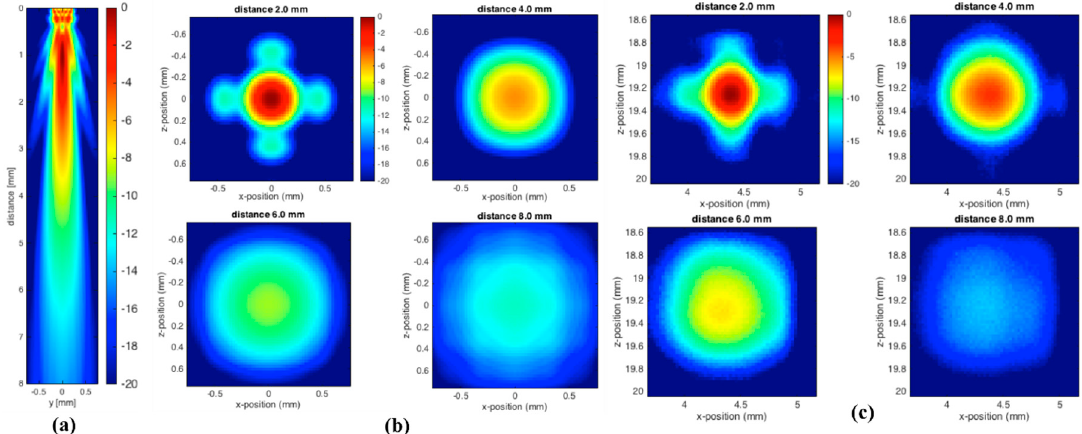
Figure 5. ( a ) Simulated ultrasonic pressure amplitudes (k-Wave results in the xz-plane) obtained for a single transducer element driven by the narrow bandwidth pulse; ( b ) numerical simulation of ultrasonic pressure field in the xy-plane at 2, 4, 6, and 8 mm; and ( c ) hydrophone measurements of a single transducer applying a narrowband Gaussian modulated signal at different distances, such as 2, 4, 6, and 8 mm, with respect to hydrophone.